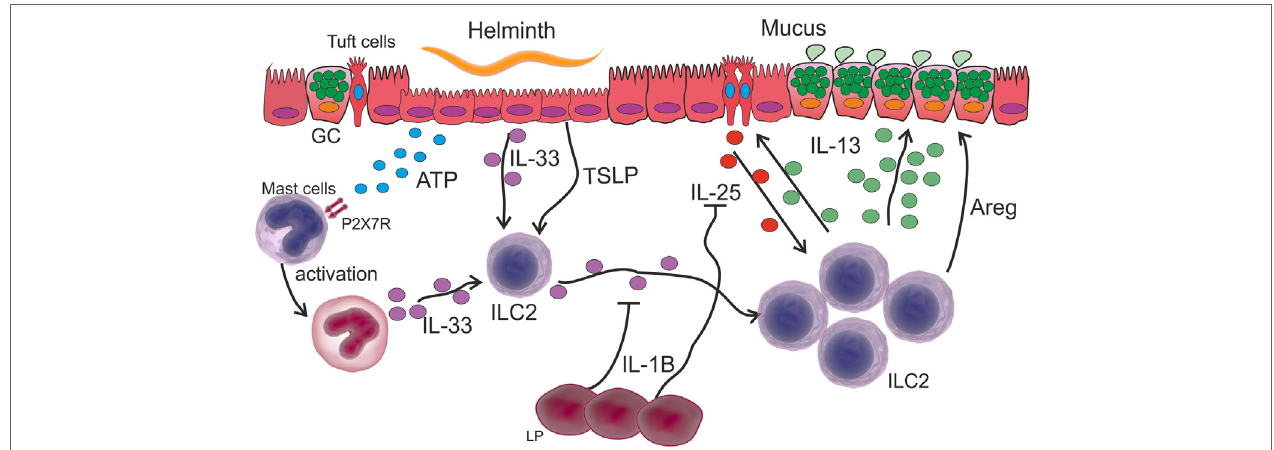
FiGURe 3 | Innate immune response in intestinal helminth infection. Tissue damage caused by intestinal helminths induces an ATP increase that is recognized by P2X7R on the surface of mast cells, which in turn are activated secreting IL-33. This cytokine together with other alarmins such as stromal lymphopoietin (TSLP) activate ILC2 and induce their proliferation. Activated ILC2 cells secrete IL-13 thereby increasing mucus secretion in goblet cells (GC). The activation of ILC2s induces the hyperplasia of tuft cells and the release of IL-25, which together with IL-33 promotes the secretion of IL-13 by ILC2 cells. IL-1 β produced by lamina propria (LP) cells inhibits IL-25 and IL-33, thereby controlling the expansion of the Th2-type